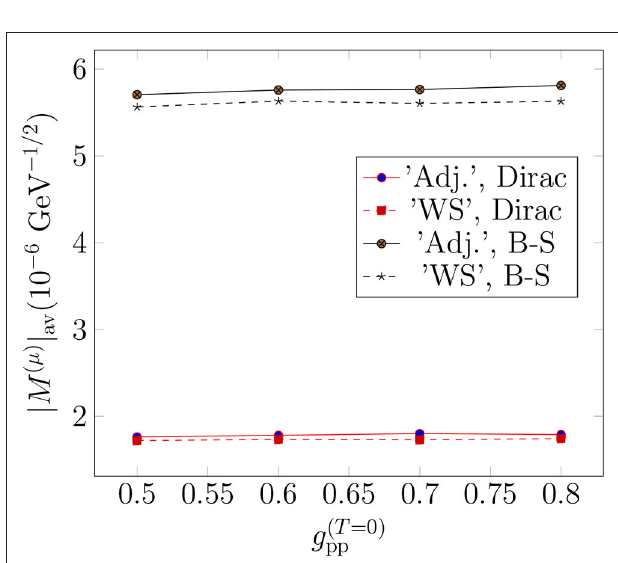
FIGURE 6 | Dependence of the average OMC matrix element on the isoscalar part of the particle-particle parameter g pp in the two different single-particle bases, and for the exact Dirac finite-nucleus and approximate Bethe-Salpeter point-like-nucleus bound-muon wave functions.